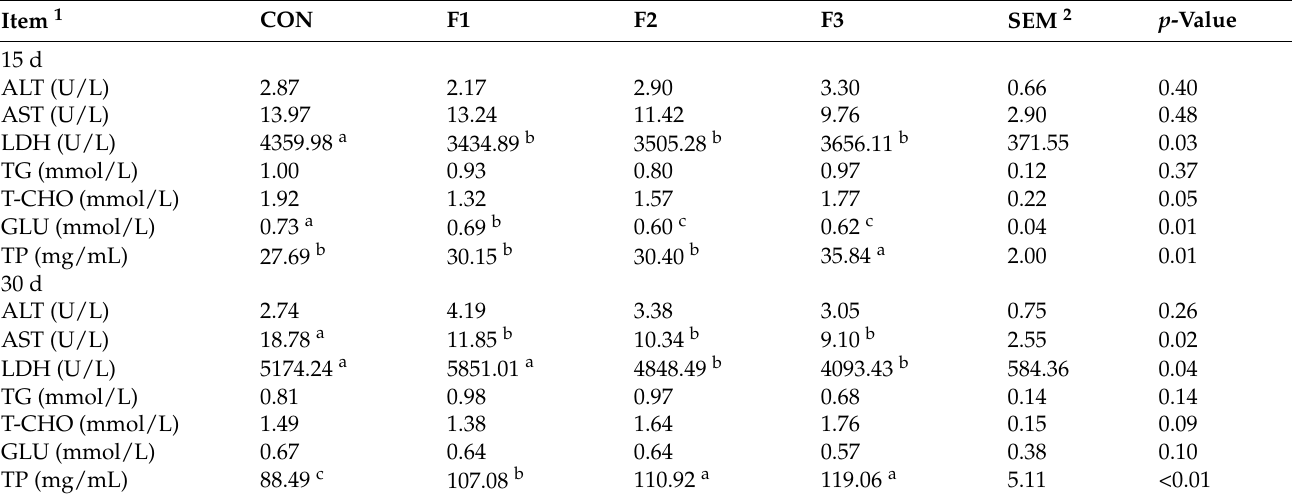
Table 3. Effects of dietary fucoidan on serum biochemical in weaned goat